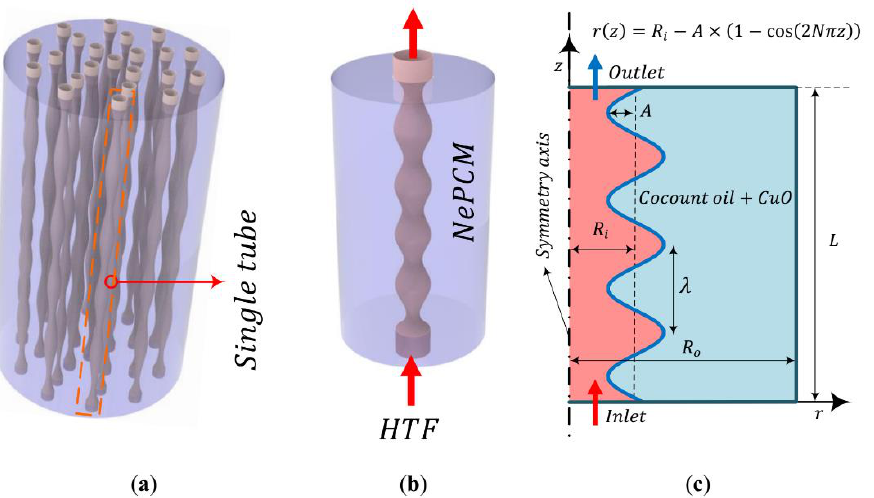
Figure 1. The model of the energy storage system: ( a ) latent heat thermal energy storage (LHTES) unit, ( b ) single tube with the nano-enhanced phase change material (NePCM) domain; ( c ) computational domain.